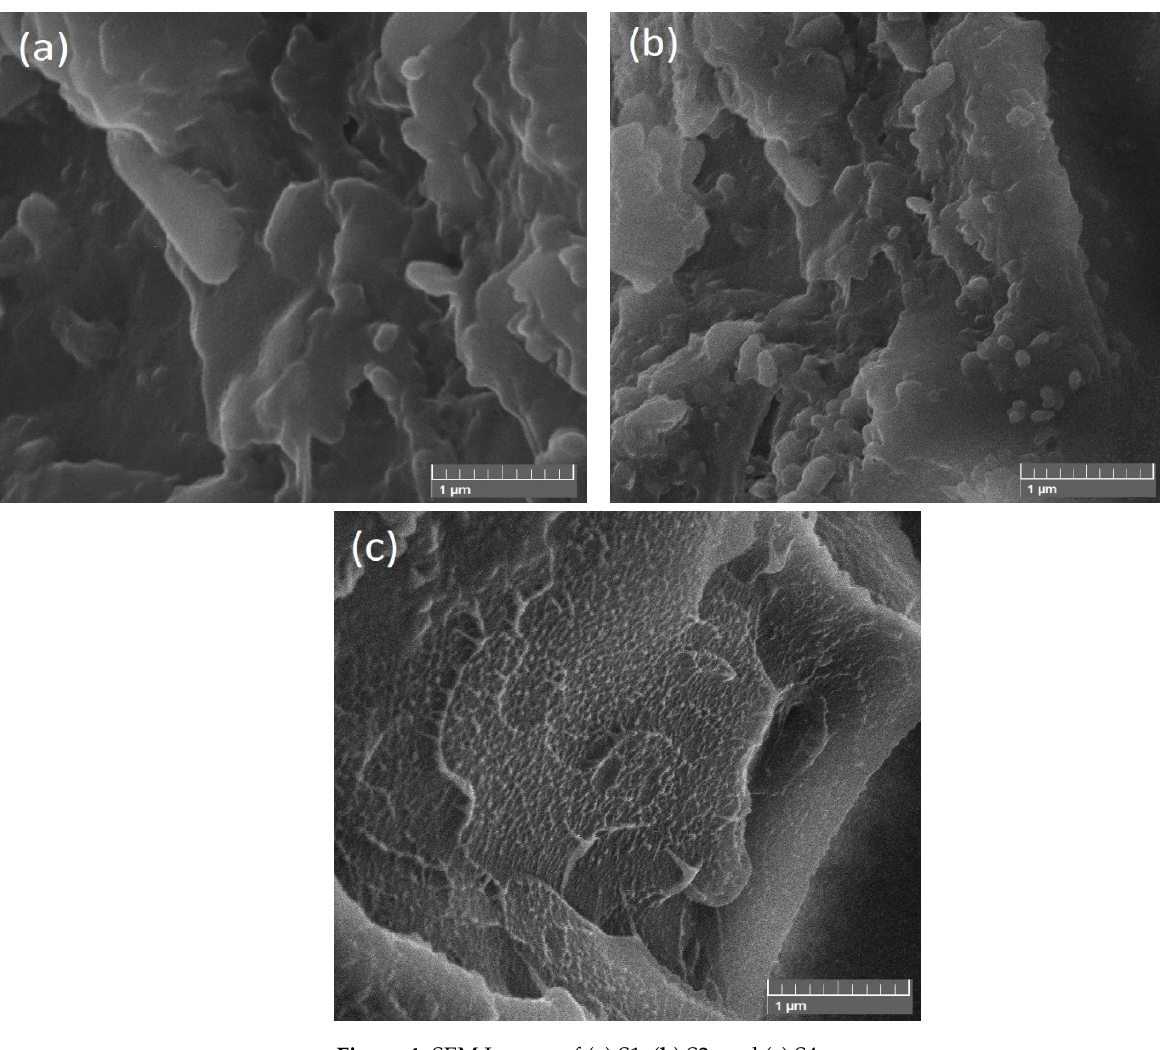
Figure 3. SEM Images of NiFe-TRGO nanoparticles on ( a ) low and ( b ) high resolution.